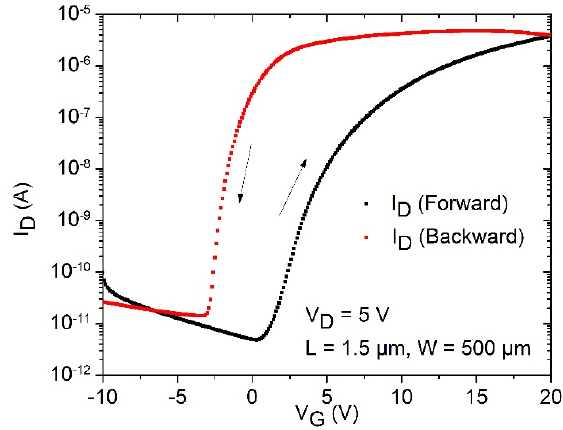
Figure 16. Transfer characteristics of an inverted staggered ZnO nanoparticle TFT using PVP as gate dielectric (L = 1.5 µm, W = 500 µm and t ins = 200